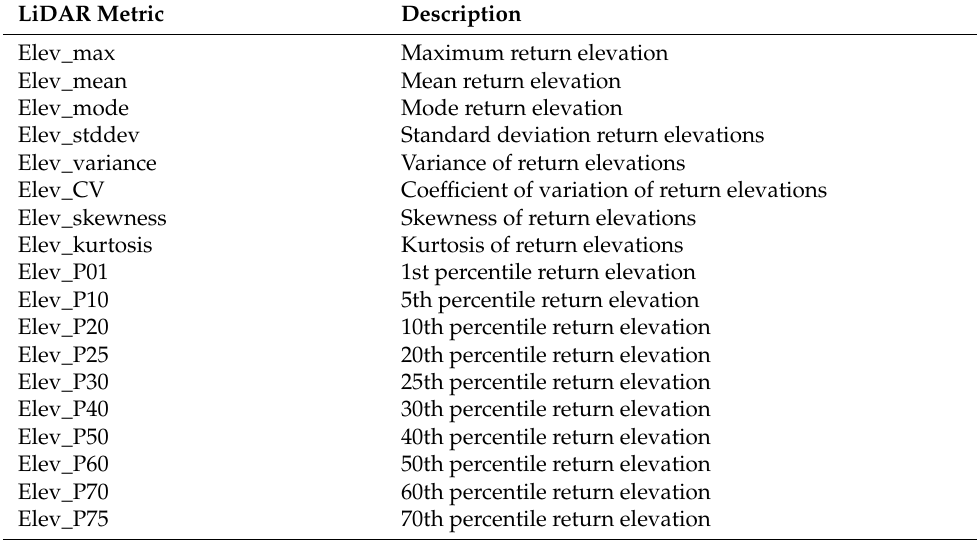
Table A1. LiDAR metrics used to develop the predictive models for CBH and LFHAC. LiDAR